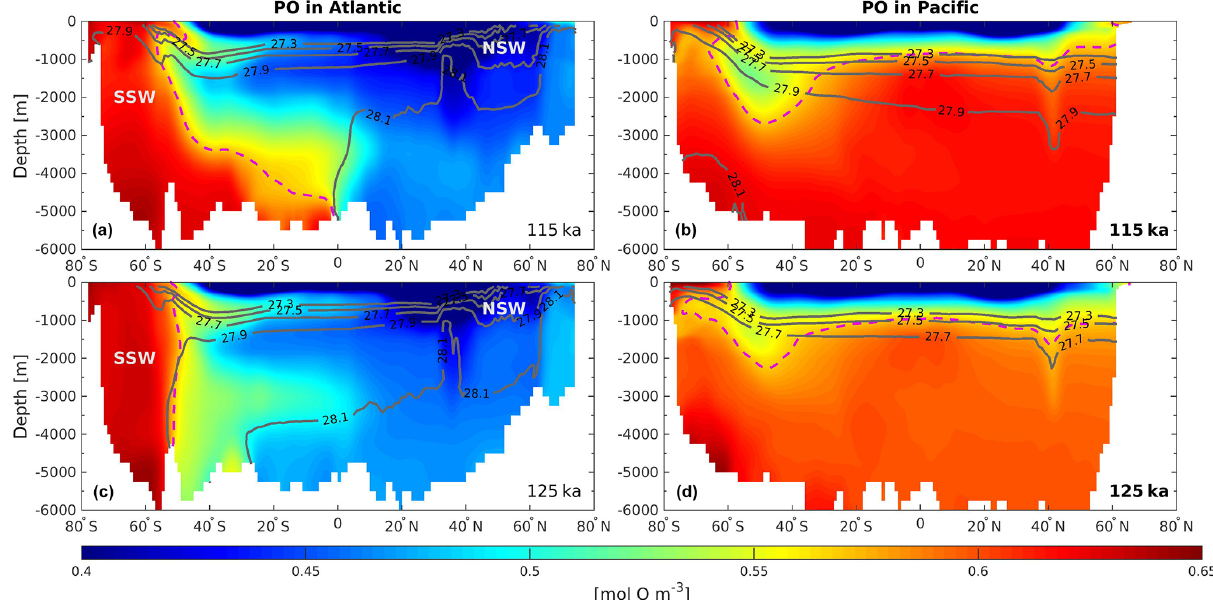
Figure 4. Zonally averaged section of PO as defined by Broecker (1974) in (a, c) the Atlantic Ocean at 115 and 125ka, respectively, and (b, d) the Pacific Ocean at 115 and 125ka, respectively. The light purple dashed lines delimit the water influenced by the SSW from water influenced by the NSW. The dark gray solid lines depict the neutral density (units: kgm − 3 ). Table 1. Difference in southern-sourced water ( (cid:49) SSW ) in the global ocean and for each basin. Row 1 shows the volume ( V SSW ) according to our PO ≥ 0 . 57molOm − 3 criteria. Rows 2 and 3 summarizes the DIC and water mass age mean value for the two period of study. The changes relative to 115ka are given as a percentage in parenthesis. Global Atlantic